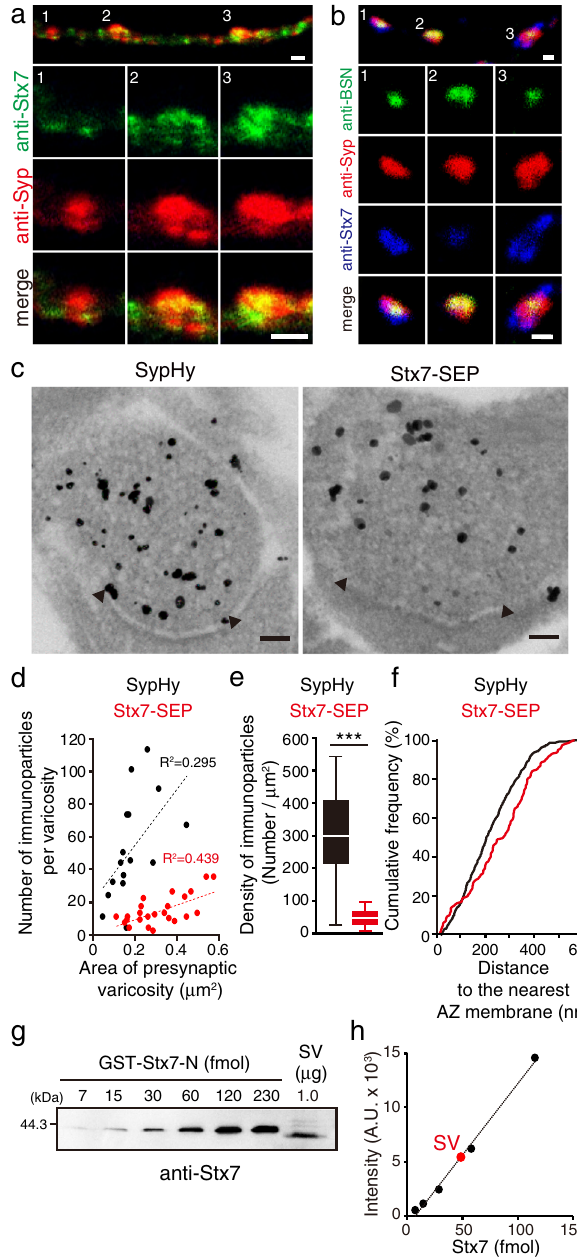
Fig. 3 Stx7 localizes to a subpopulation of SVs at presynaptic terminals. a Double immunostaining of Stx7 and Syp in cultured hippocampal neurons at 14 DIV. An upper panel shows representative axonal localization of Stx7 (green) and Syp (red). Magni fi ed images of numbered areas (1 − 3) are shown individually below. The speci fi city of the Stx7 antibody was con fi rmed in independent experiments where Stx7 expression level was reduced by speci fi c shRNA (Supplementary Fig. 14b). Scale bars indicate 2 µ m. b Triple-immuno fl uorescence for Stx7 (blue), Syp (red), and an active zone maker Bassoon (BSN, green). An upper panel shows representative images. Magni fi ed images of the numbered areas (1 − 3) are shown below. Scale bars indicate 1 µ m. c Immunoelectron micrographs of SypHy (left) and Stx7-SEP (right) at presynaptic terminals. Immunogold labeling was intensi fi ed by silver enhancement. Arrowheads indicate both edges of the active zone deduced from postsynaptic density structures. Scale bars indicate 100 nm. d Number of immunoparticles as a function of the area of presynaptic varicosity. Sixteen varicosities for SypHy (black) and 24 varicosities for Stx7-SEP (red) were analyzed. e A box-whisker plot showing densities of SypHy immunoparticles (black) and Stx7-SEP immunoparticles (red) calculated from ( d ). p < 0.0001 with unpaired t -test with Welch ’ s correction. f A cumulative plot of distances of immunoparticles to the nearest AZ membrane. Note that vertical lines from the edges of AZs were drawn manually, and only immunoparticles inside the enclosed areas were measured for the analysis (Supplementary Fig. 9). Statistical signi fi cance was evaluated with Kolmogorov − Smirnov test ( p = 0.0003). g A representative quanti fi cation of Stx7 in native SVs puri fi ed from rat brains. Various amounts of recombinant GST-Stx7-N-terminal domain (GST-Stx7- N) and a fi xed amount of puri fi ed SV fraction (vesicle concentration, 26.7 nM; protein concentration, 99.7 ng/ μ L) were subjected to quantitative western blot analysis (see also Supplementary Fig. 10 for complete datasets and control experiments for Syb2). h Signal intensities of bands were quanti fi ed and plotted as a function of moles of GST-Stx7-N. A red circle indicates the signal intensity measured for 1.0 µ g SV shown in ( g